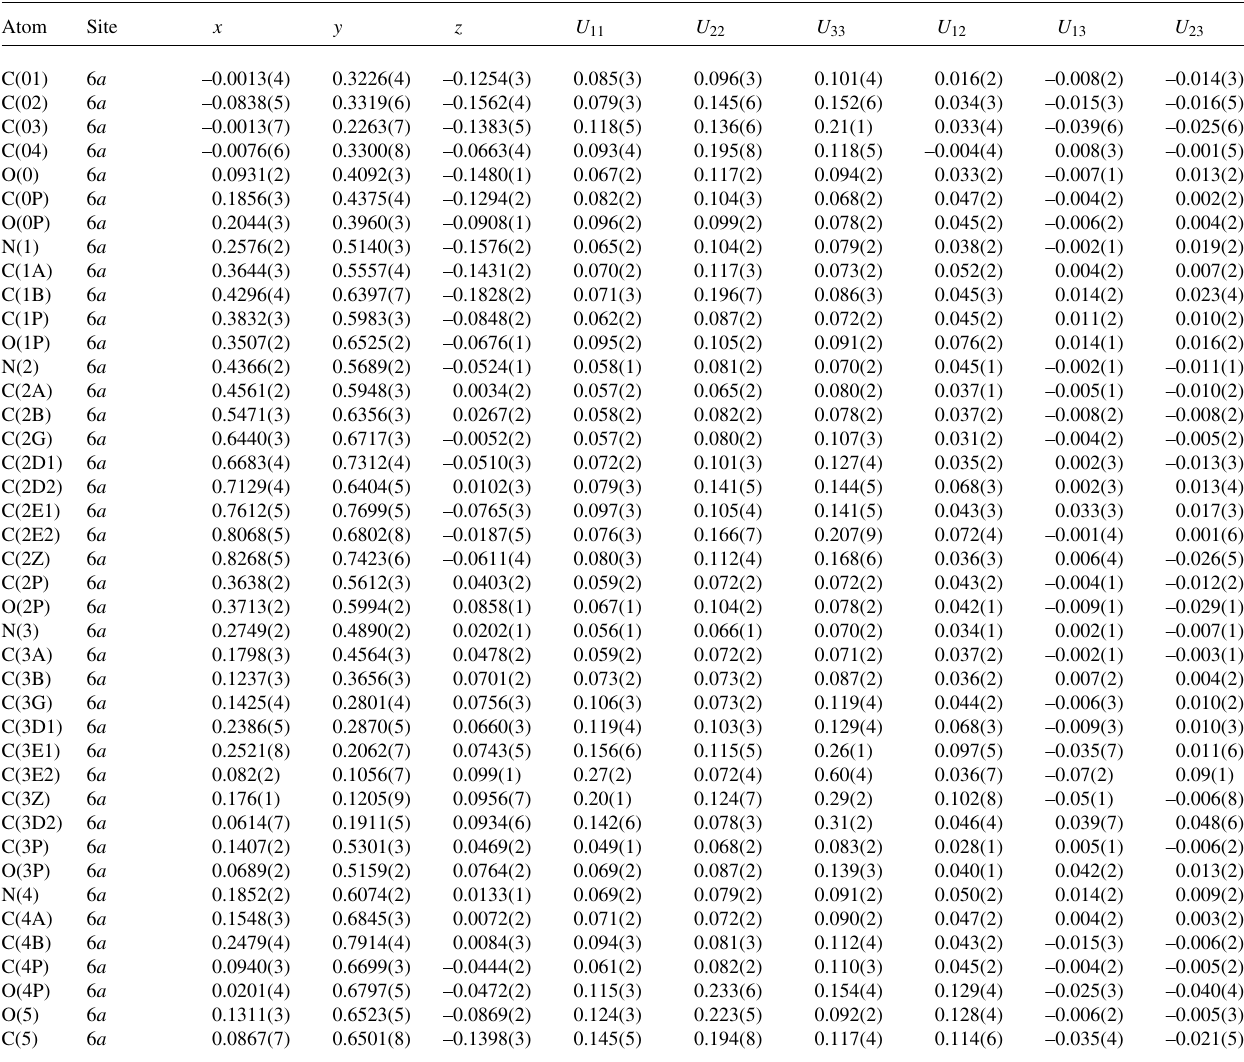
Table 3. Atomic coordinates and displacement parameters (in Å 2 )